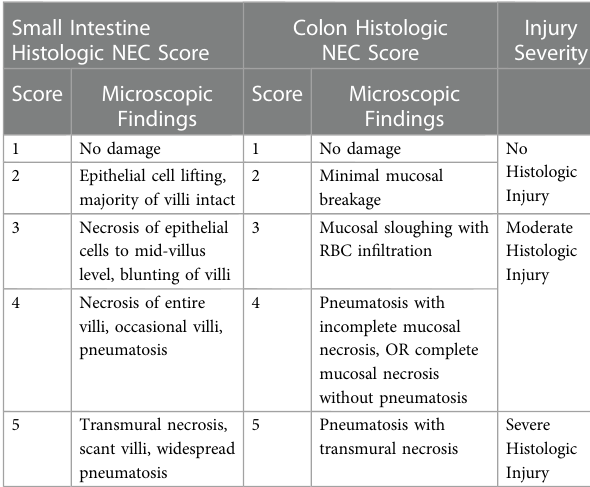
TABLE 3 Histologic injury scoring system. Histologic injury scores were assigned to the proximal small intestine, mid small intestine, distal small intestine, and colon of each animal. The fi nal score assigned to an animal was the highest score in any given section. Scores of 1 – 2 were considered no histologic injury, scores of 3 – 4 were considered moderate histologic injury, and a score of 5 was considered severe histologic